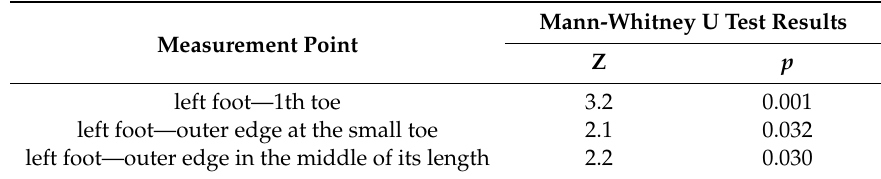
Table 5. Statistically significant di ff erences in tactile sensitivity among women with Turner syndrome treated with estrogen replacement therapy and non-treated